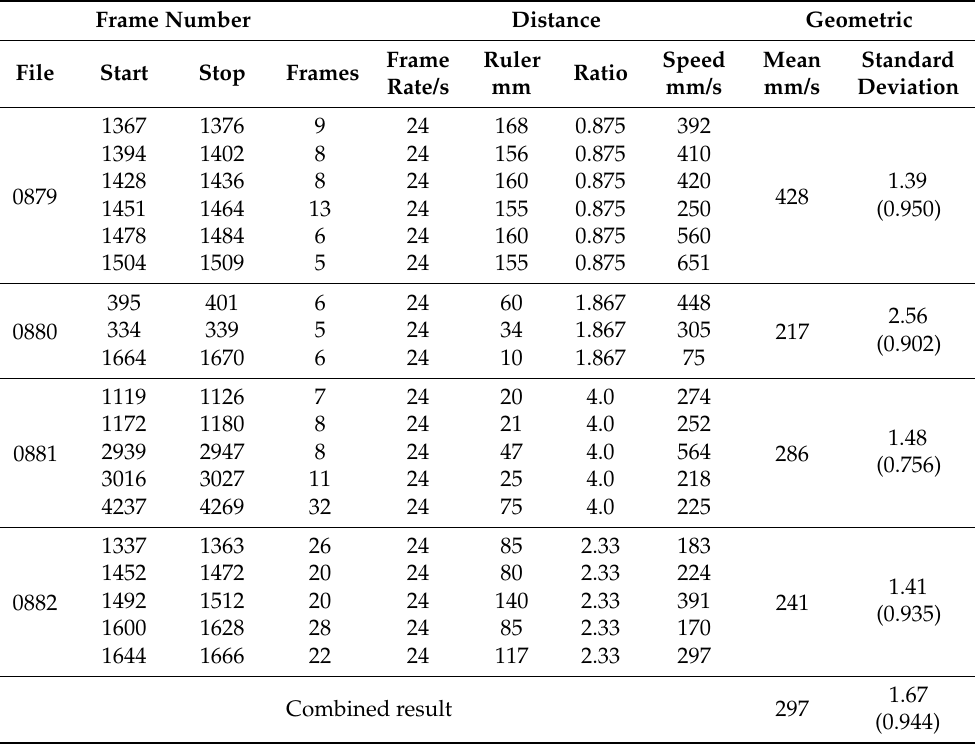
Table 1. Air motion along the surface of the ground removed from the opening under